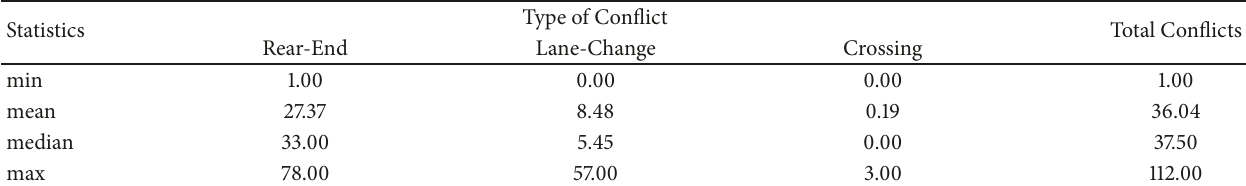
Table 7: Summary of main statistics for type of conflict and total